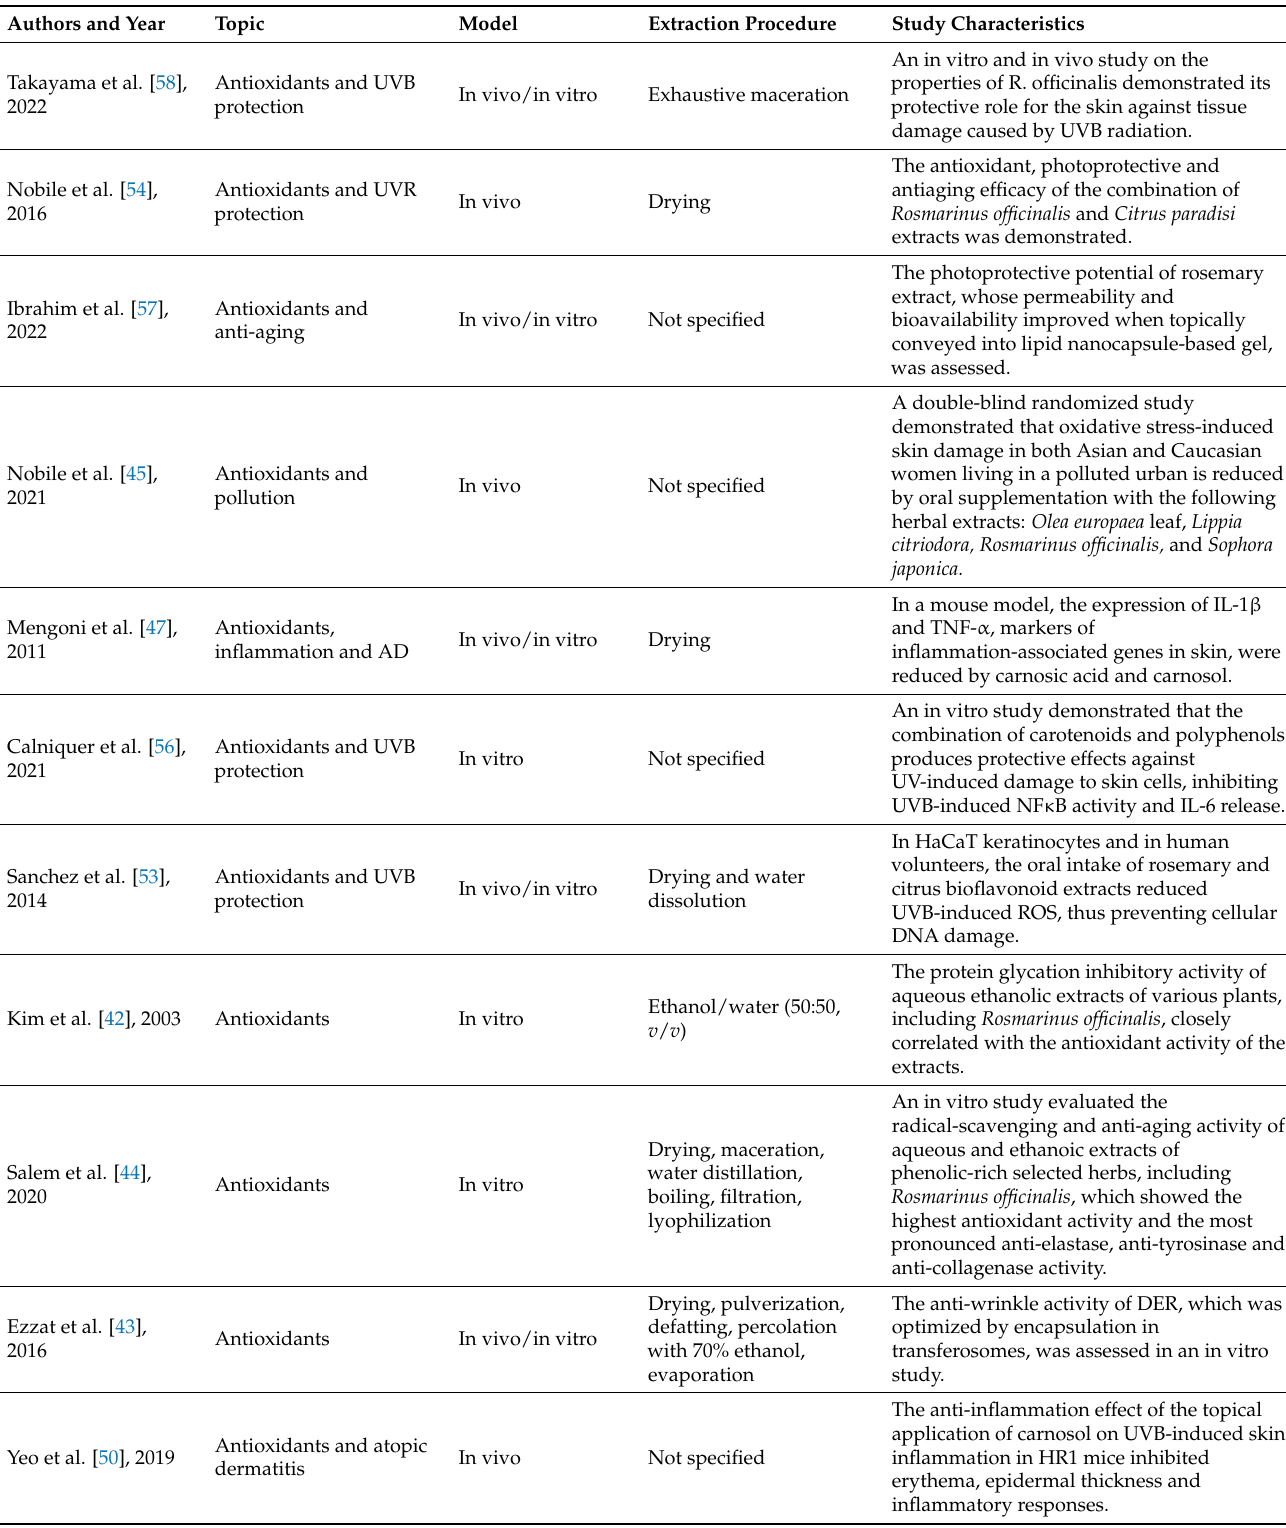
Table 1. The role of Rosmarinus officinalis against oxidative